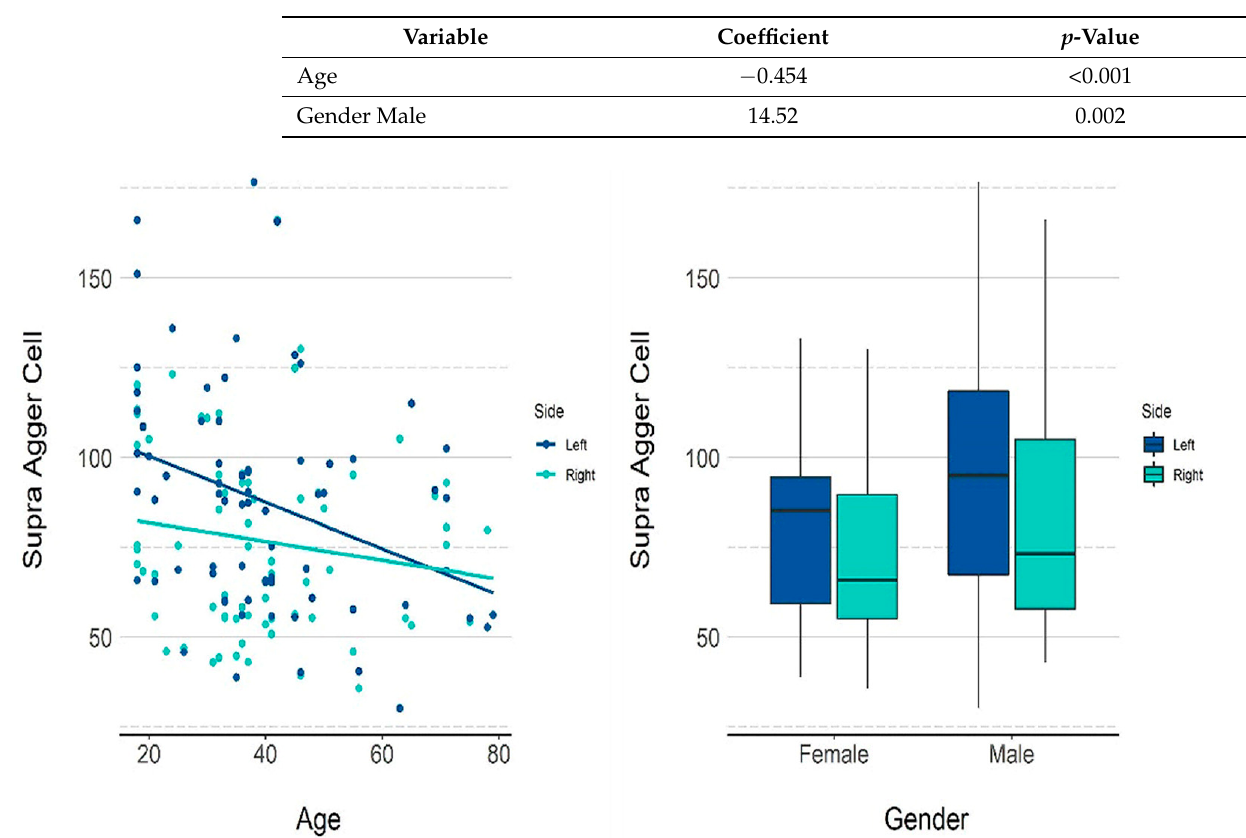
influence of age and gender on the volume of supra agger cell.